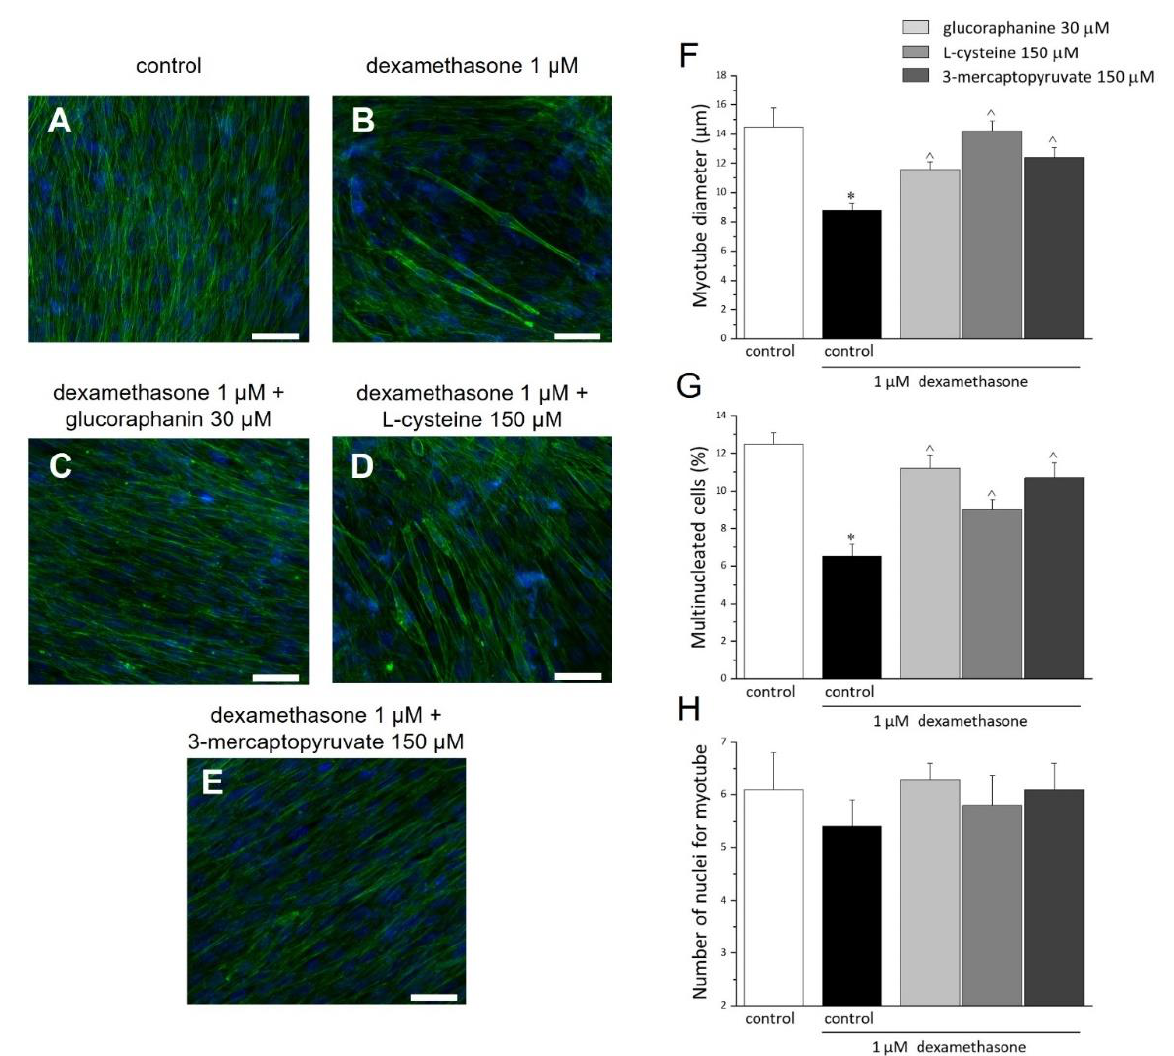
Figure 6. Morphological and morphometric analysis of C2C12 myotubes. C2C12 myoblasts were cultured in DM for 7 days. Once differentiated in myotubes, cells were incubated for 48 h with DM ( A , control); with 1 µ M DEX in the absence ( B ) or presence of 30 µ M glucoraphanin ( C ), 150 µ M L-cysteine ( D ), and 150 µ M mercaptopyruvate ( E ). Cells were fixed and stained with FITC-conjugated phalloidin to highlight F-actin organization (green) and with DAPI, for nuclei staining (blue). Scale bar (white line): 50 µ m. Morphometric analyses were carried out to provide: the length in µ m of the myotube diameter ( F ); the multinucleated cells percentage ( G ) (percentage ratio of the number of multinucleated cells and the number of total cells, considered as 100%); and the number of nuclei in each myotube ( H ). The analyses were conducted in at least 3 random fields of each experimental group. Values are expressed as the mean ± S.E.M. of 3 different experiments. * p < 0.05 versus control; ^ p < 0.05 versus DEX.